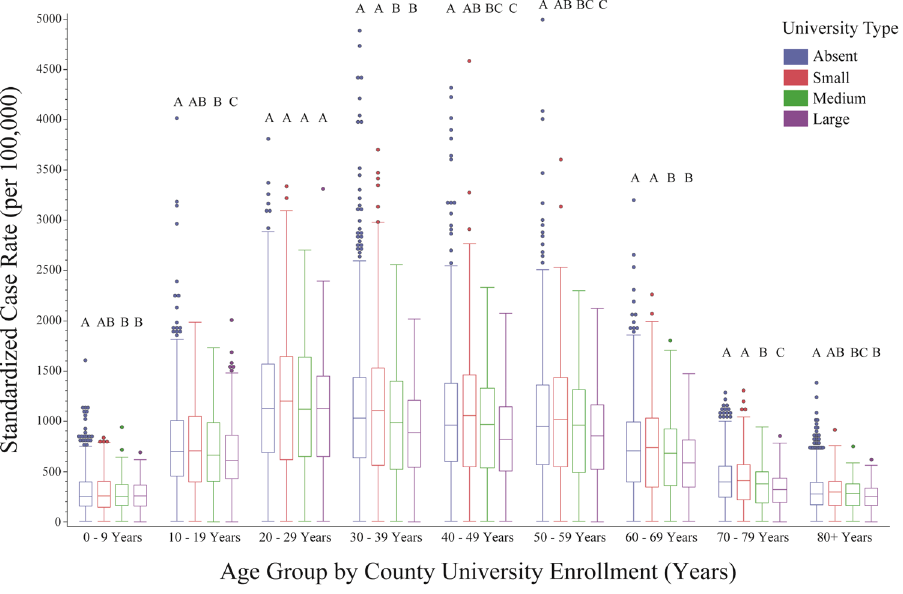
Figure 2. Box plot breakdown of laboratory-confirmed mean SARS-CoV-2 age-adjusted case rates (per 100,000) by age-group (binned by 10-year intervals). Unique letters, arranged in descending order (highest mean value = A and so on), indicate statistically different groups, assessed by Student’s t-test ( p value ≤ 0.05). Individual circles represent outlier